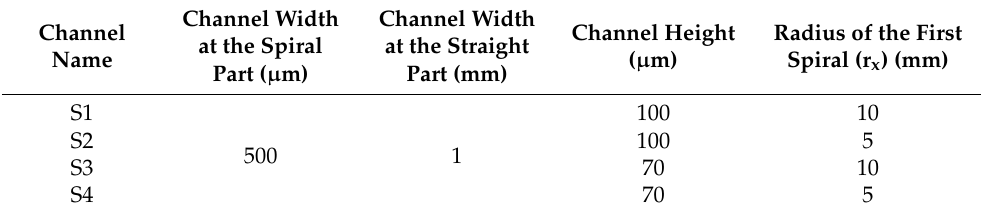
Table 1. Common geometrical parameters and dimensions of the microchannels which are named as S1, S2, S3, and